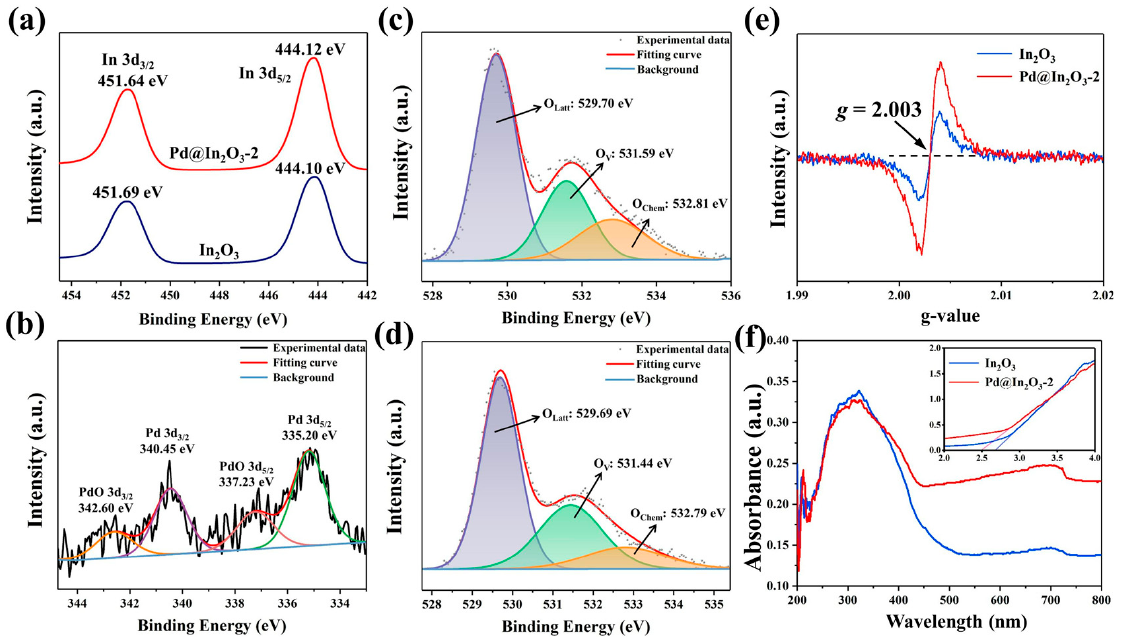
Figure 5. XPS spectra of the elements: ( a ) In 3d of pristine In 2 O 3 and Pd@In 2 O 3 -2, ( b ) Pd 3d of Pd@In 2 O 3 -2, O 1s of ( c ) pristine In 2 O 3 and ( d ) Pd@In 2 O 3 -2; characterization of oxygen vacancies: ( e ) electron paramagnetic resonance spectra, ( f ) UV-vis absorbance spectra, the inset is curves of ( α h ν ) 2 vs photo energy (h ν ).